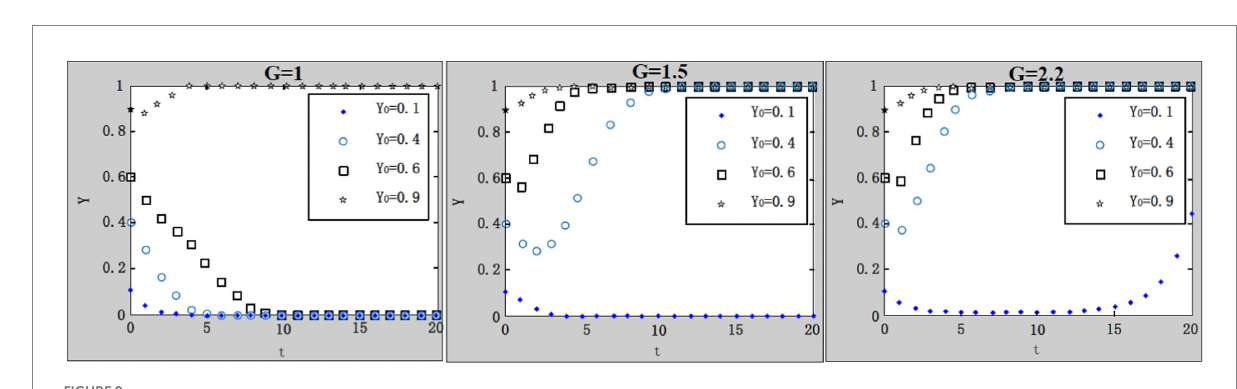
FIGURE 9 Influence of central government’s penalties on local government’s loose supervision on system evolution.